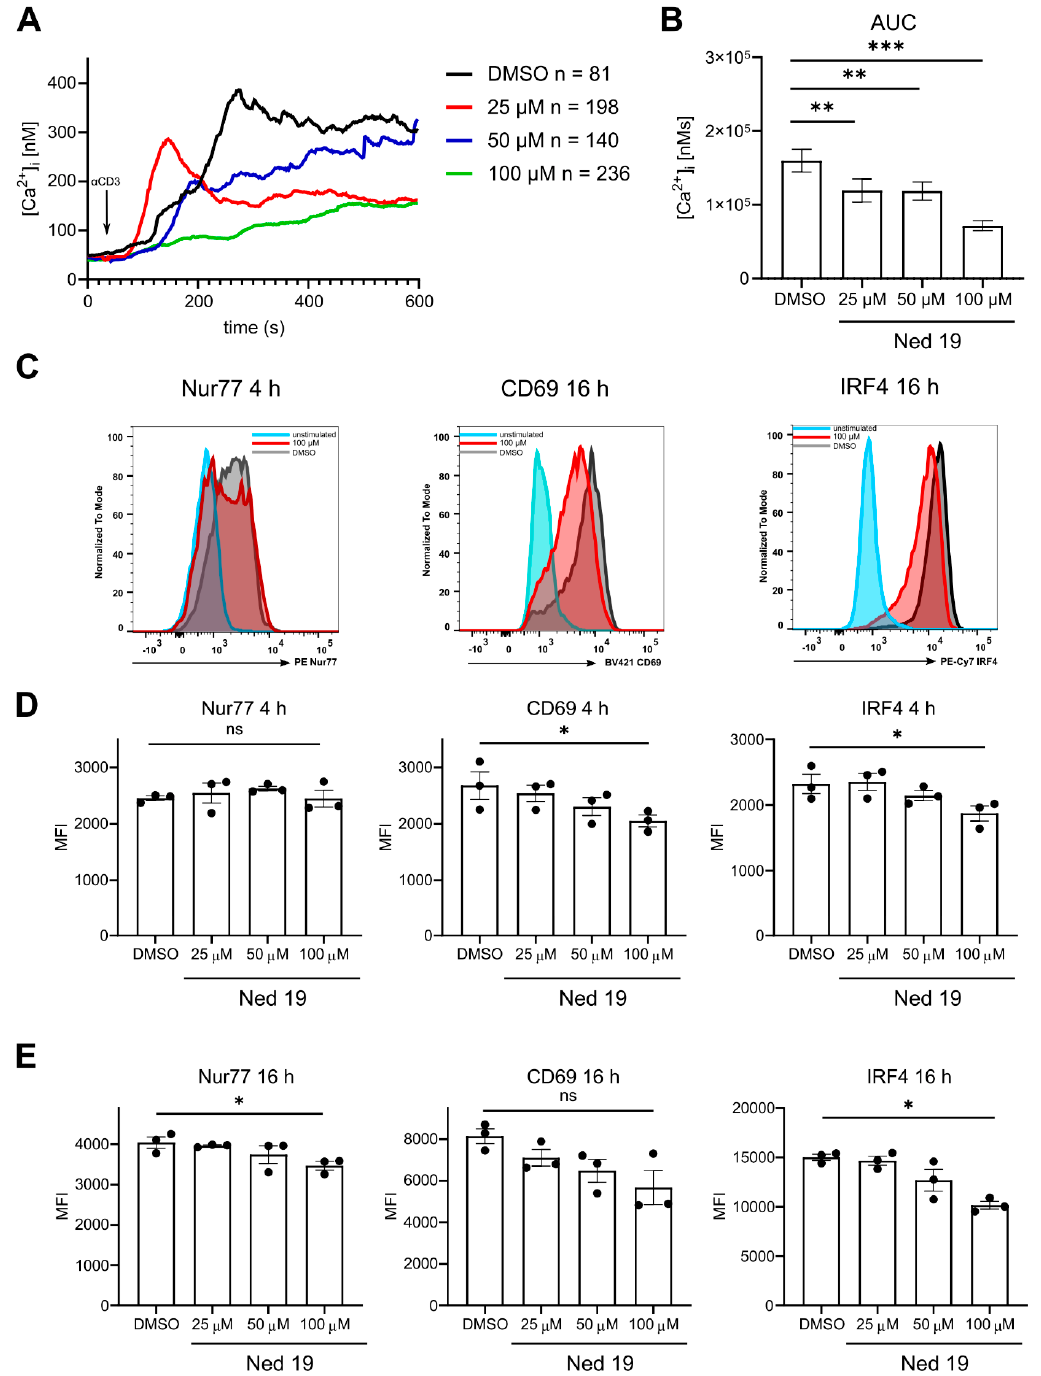
Figure 1. Trans-Ned 19 impairs Ca 2+ and cell activation upon TCR stimulation. The naïve CD4 + T cells were freshly isolated from WT C57BL/6N mice, then incubated with increasing concentrations of trans-Ned 19 for 1 h. For Ca 2+ signaling measurements, cells were loaded with Fura2-AM before incubation with trans-Ned 19. ( A ) Analysis of global Ca 2+ measurements in naïve WT CD4 + T cells, showing mean Ca 2+ traces upon soluble anti-CD3 mAb stimulation (2 µg/mL). ( B ) The area under the curve (AUC) of cytosolic [Ca 2+ ] i measured in the activated cells. ( C ) Representative flow cytometry histogram showing the expression of Nur77 at 4 h and CD69 and IRF4 at 16 h after activation. For these experiments, naïve CD4 + T cells were stimulated by plate bound anti-CD3 mAb (2 µ g/mL) and soluble anti-CD28 mAb (1 µ g/mL). ( D ) Pooled statistics of mean fluorescence intensity (MFI) of Nur77, CD69 and IRF4 measured 4 h after T-cell activation. ( E ) Pooled statistics of MFI of Nur77, CD69 and IRF4 measured 16 h after T-cell activation. Presented data are mean ± SEM. For ( B ), the p -values were calculated with ordinary one-way ANOVA with Dunnett’s multiple comparison test. For ( D ) and ( E ), p -values were calculated with Kruskal-Wallis multiple comparisons test. * p < 0.05, ** p < 0.01,*** p <